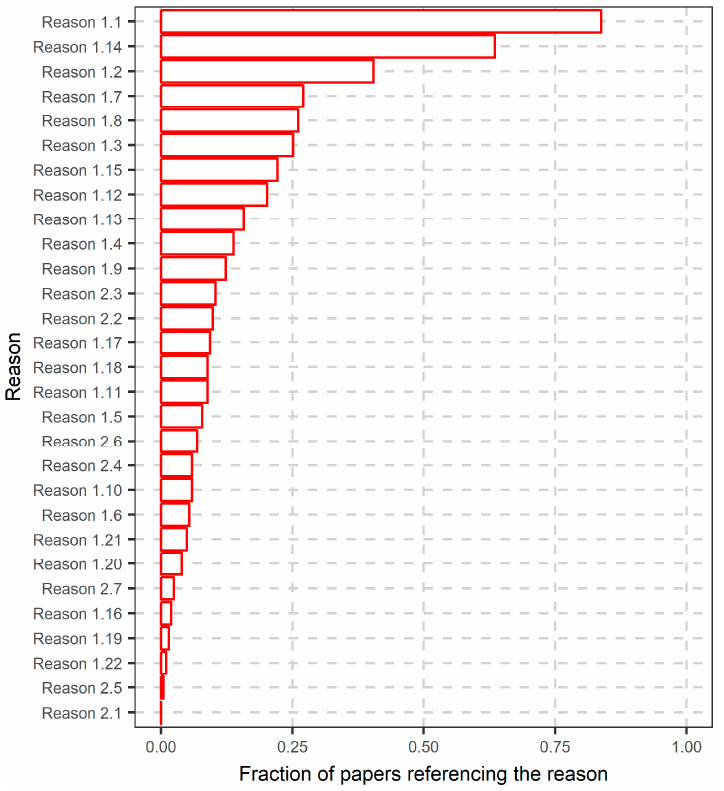
Figure 8. Reasons (see Sections 2.8.1 and 2.8.2) for implementing random forests.